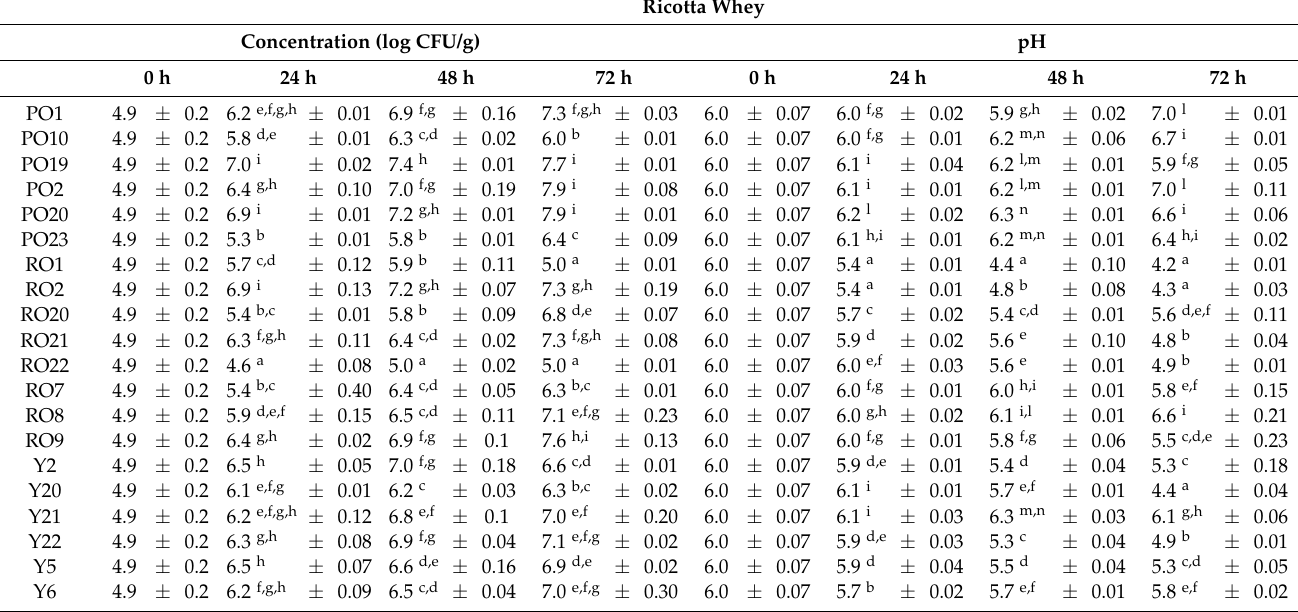
Table 3. Concentrations of Y. lipolytica in ricotta whey and pH over time. Results are the mean of three different measurements. Different letters mean significant differences ( p < 0.05) within a timepoint. Ricotta